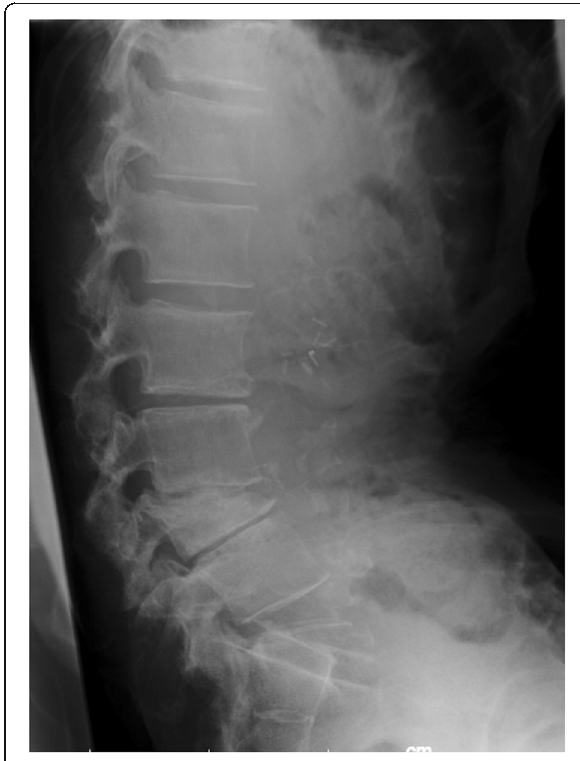
Fig. 1 A radiograph of lateral lumbar spine. Compression fracture of L4 vertebral body is